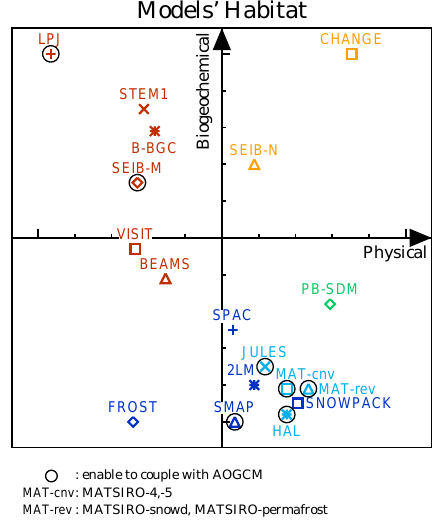
Figure 4. The habitat of models participating in the GTMIP. The vertical and horizontal axes show the ratio of the incorporation of biogeochemical processes and physical processes,